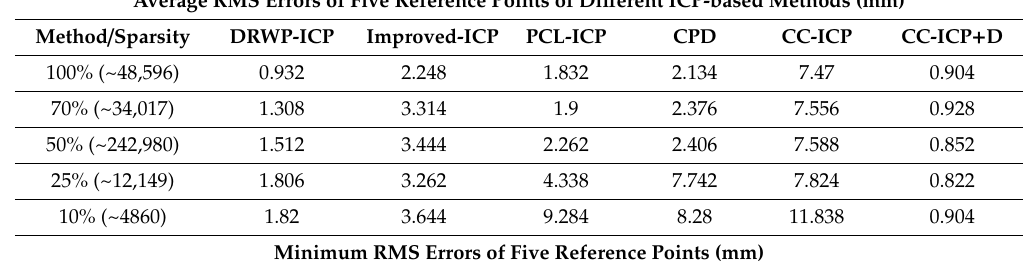
Table 8. The Average, Minimum and Maximum of Reference Points’ Alignment Errors .